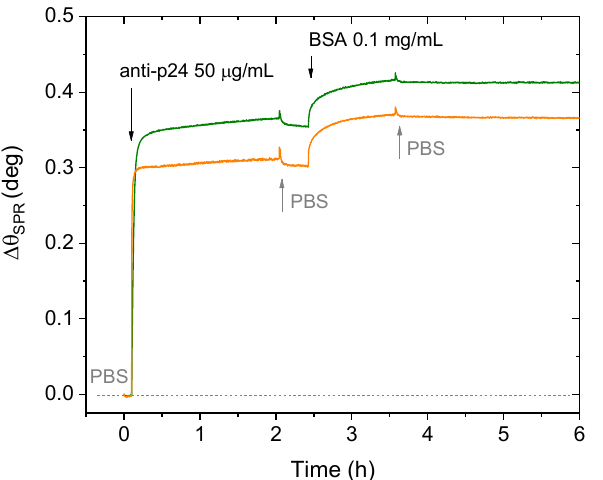
Figure 2. SPR sensogram of the anti-p24 physisorption on the gold surface and the subsequent BSA blocking. Green and orange curves refer to the surface inspection performed by the two laser beams in two different points of the sample points.